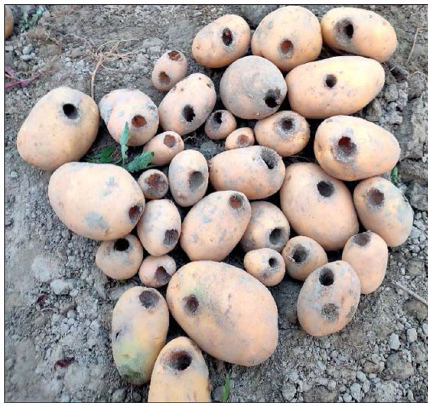
Fig. 1 Lepidiota mansueta grubs infested potato tubers